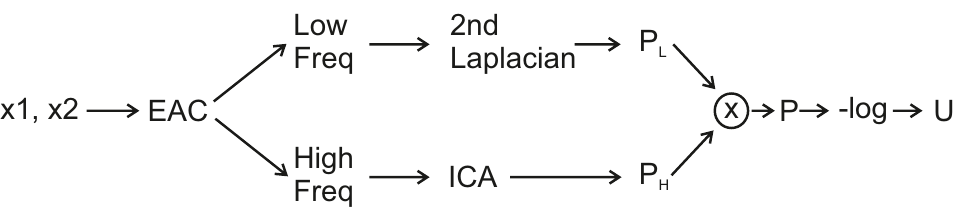
Figure 5. Unary potential estimation for CRF-Guided